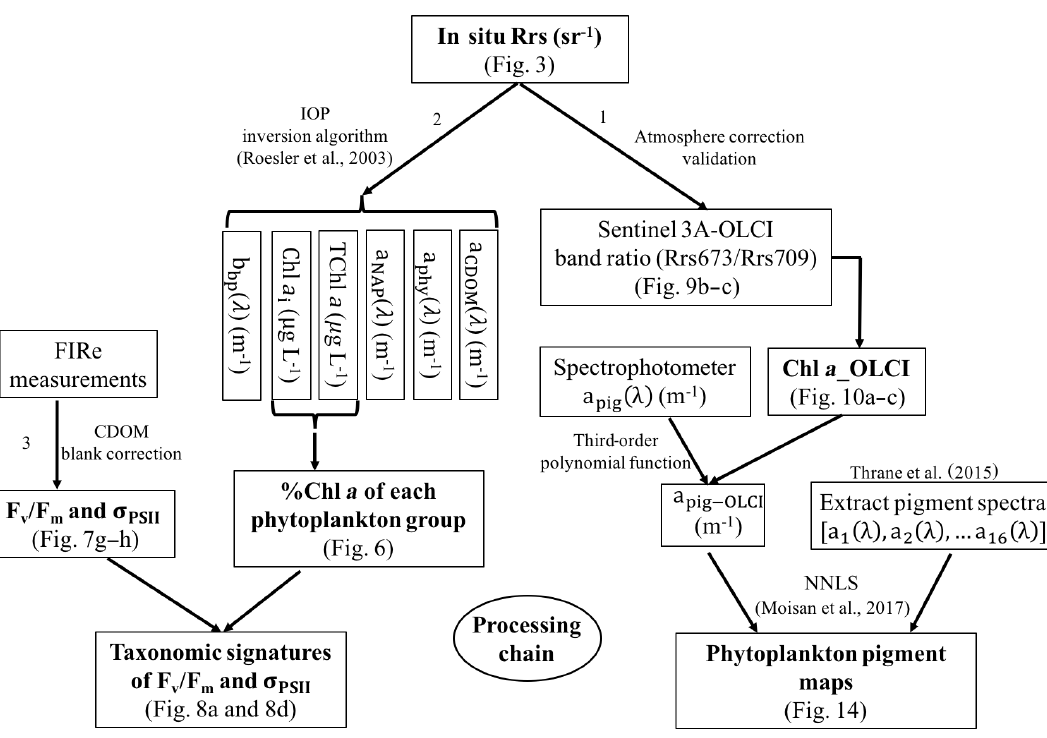
675 nm) caused by Chl a red light absorption and